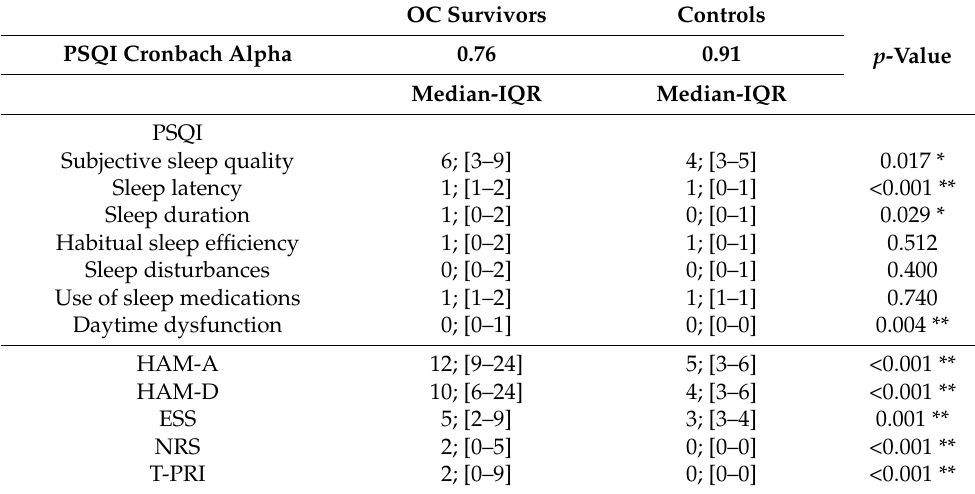
Table 4. Differences in sleep quality, anxiety, depression and pain in 50 OSCC patients and 50